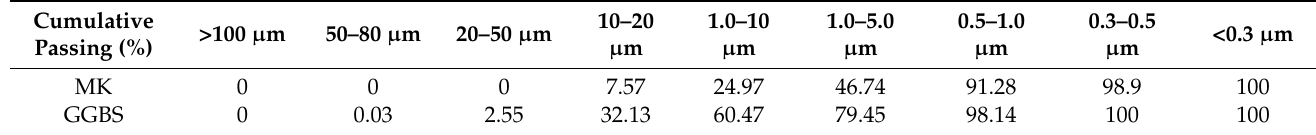
Figure 2. Precursor property: ( a ) size distribution of the precursors; ( b ) X-ray diffraction patterns of the precursors. Table 2. Size distribution of the precursors.